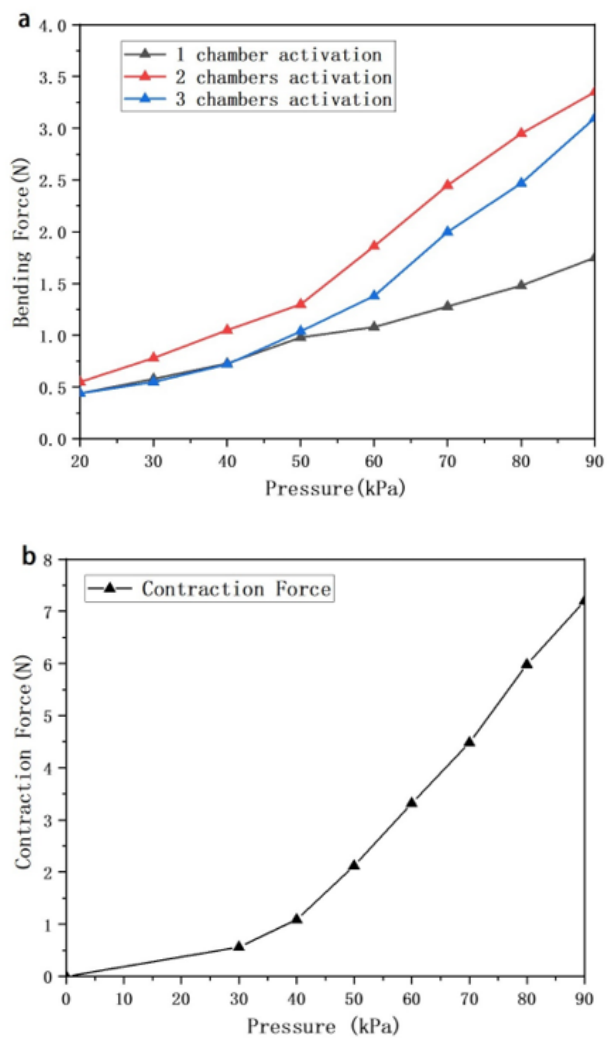
Figure 9. Curve of output force vs. air pressure: ( a ) measured bending force when one, two, and three chambers of the actuator are activated; ( b ) measured contraction force when four chambers of the actuator are actuated.